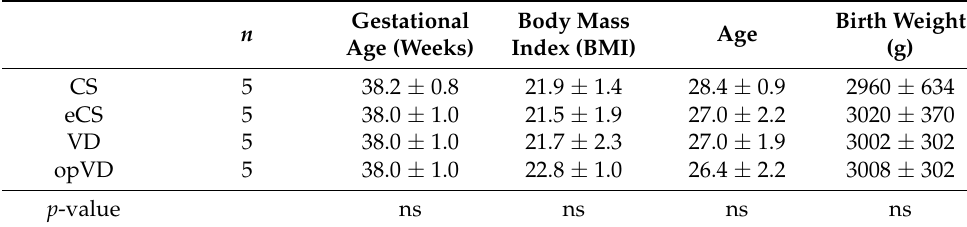
Table 1. Clinical information of patients for delivery mode analysis. Mean value ± standard deviation is shown. CS, caesarean section; eCS, emergency caesarean section after the onset of labor; VD, vaginal delivery; opVD, operative vaginal delivery; ns, not significant.